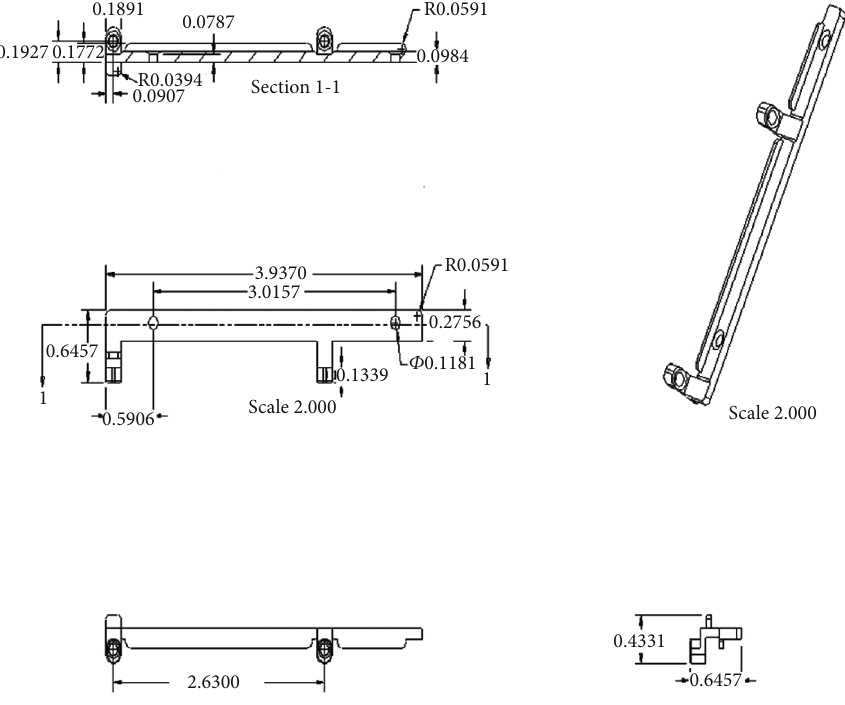
Figure 1: Dimensions of the thin-walled part (units: cm).